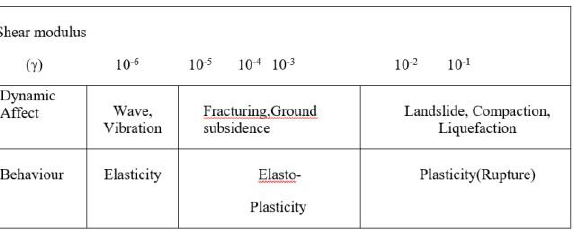
Table 2 . Soil layer and bedrock layer strain relation (reproduced from Nakamura, 1997).